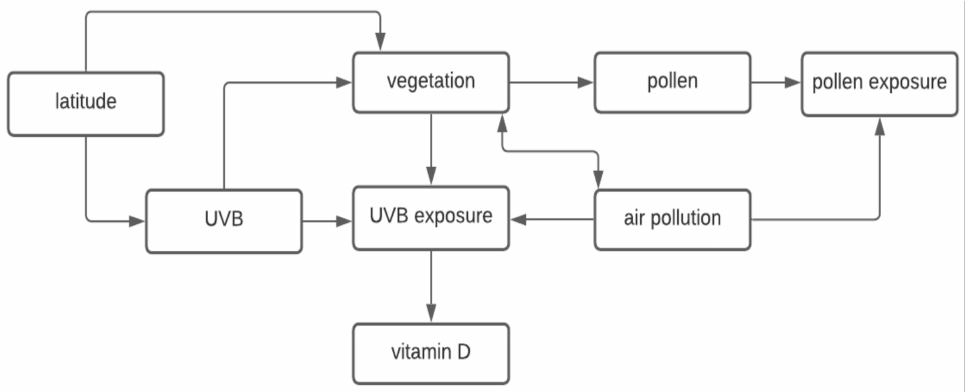
Figure 1. The interplay between environmental factors that may be relevant for food allergy develop-